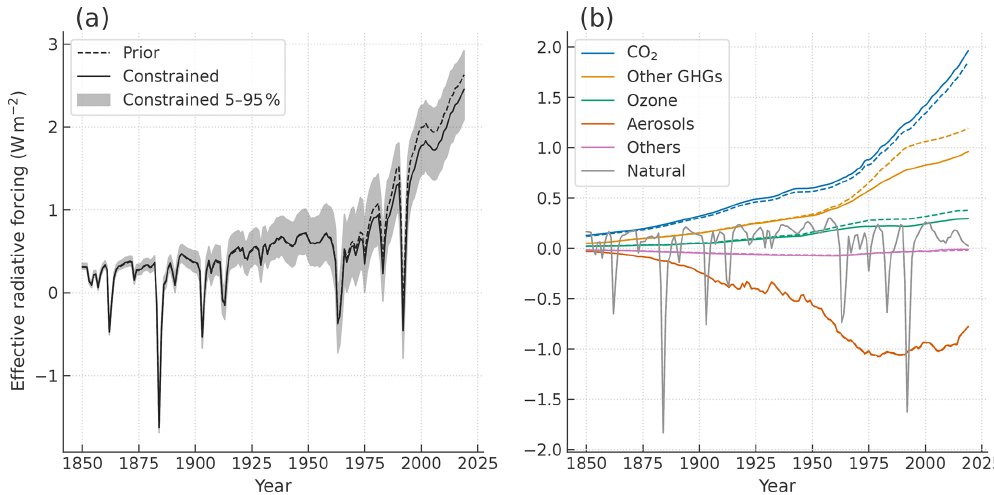
Figure 11. Historical effective radiative forcing (ERF) in the period 1850–2019 for total ERF (a) and aggregated components (b) . The ensembles’ medians are shown by lines, and the 5%–95% range of the Constrained ensemble is shown for the total by